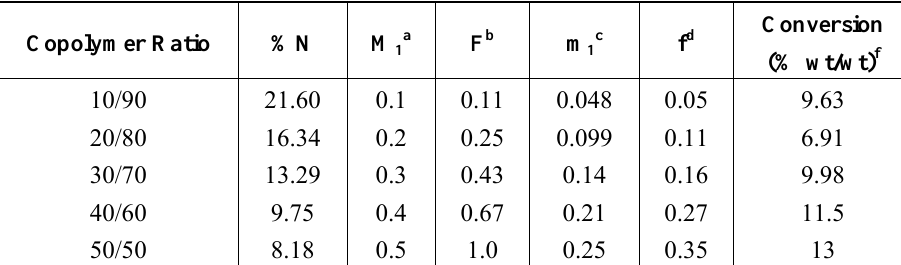
Table 1. The experimental percentage of nitrogen of poly(DTBTC- co -VI) ( II ) with different ratios and its composition parameters.